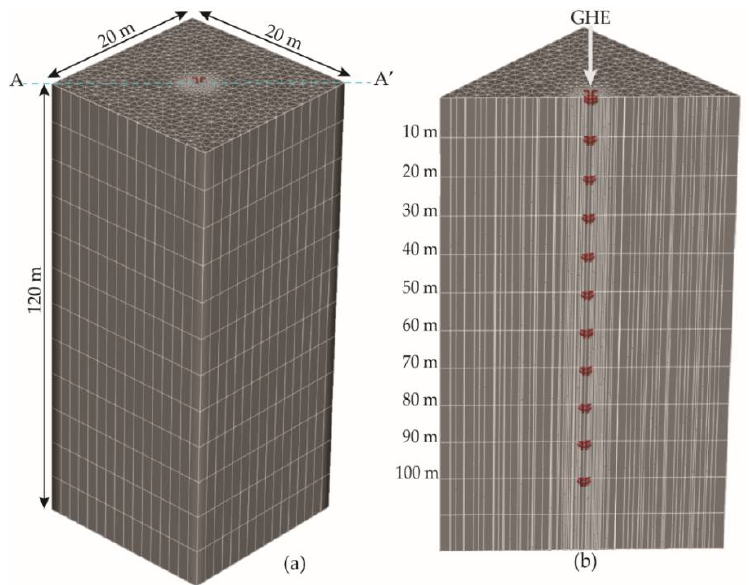
Figure 5. Ground heat exchanger (GHE) model. ( a ) Three-dimensional model; ( b ) cross-sectional view at A–A’.